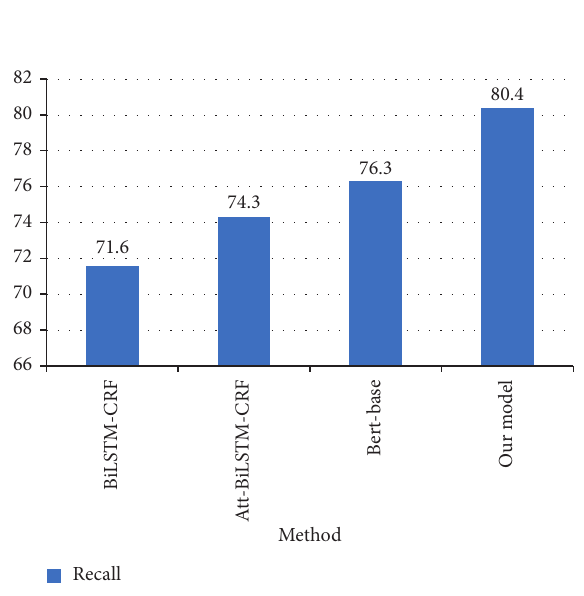
Figure 2: Recall of different methods.